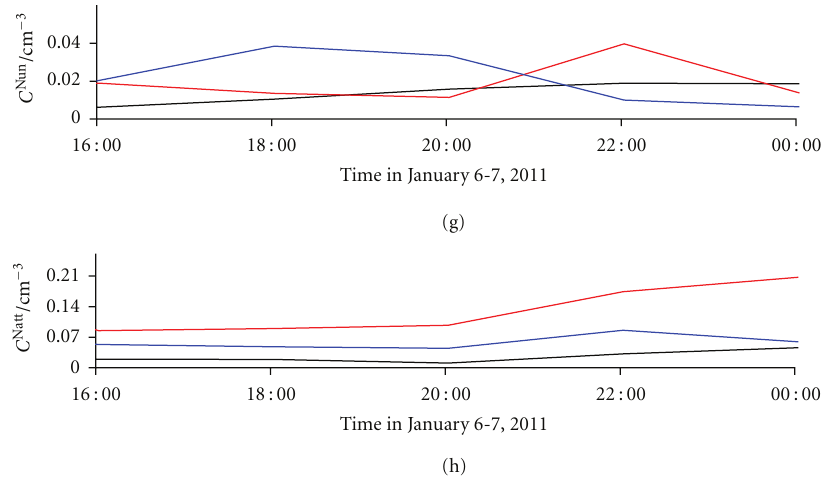
Figure 22: Time run of: (a) total number concentration of general aerosol particles ( C N (tot)) and geometric mean values of their diameters gen ( d GM ), (b) activity concentration of radon ( C A ) and equilibrium equivalent activity concentration of radon decay products ( C A ), (c) Rn RnDP number fraction of particles smaller than 10 nm ( x gen ( < 10)) and smaller than 20 nm ( x gen ( < 20)), (d) activity fraction of the unattached RnDP , C Aun 214 , and ( f un ) and number fraction of the unattached RnDP ( x un ), (e) activity concentrations of the unattached RnDP atoms ( C Aun 218 Pb Po C Aatt C Aatt C Aatt C Aun 214 Bi ), (f) activity concentrations of the attached RnDP atoms ( 218 Po , 214 Pb , and 214 Bi ), (g) number concentrations of the unattached , C Nun 214 , and C Nun 214 ), and (h) number concentrations of the attached RnDP atoms ( C Natt 218 , C Natt 214 , and C Natt 214 ), in RnDP atoms ( C Nun 218 Pb Bi Pb Bi Po Po indoor air on January 6 (boiling water in the kitchen from 20:00 to 20:12).